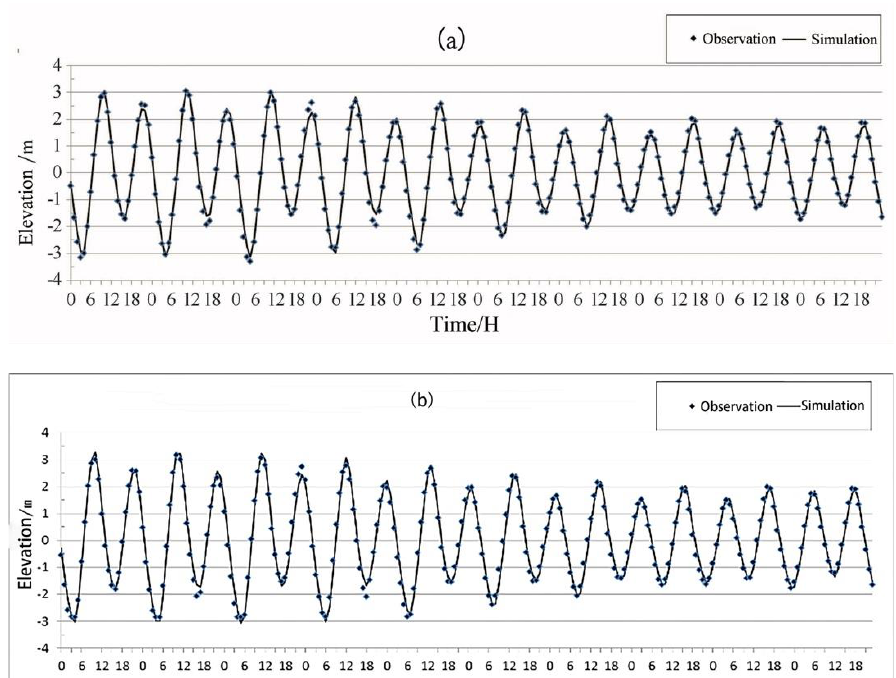
Figure 2. Tidal elevation in ( a ) Jiantiao station and ( b ) Gangdi station (2 December 2009 to 12 December